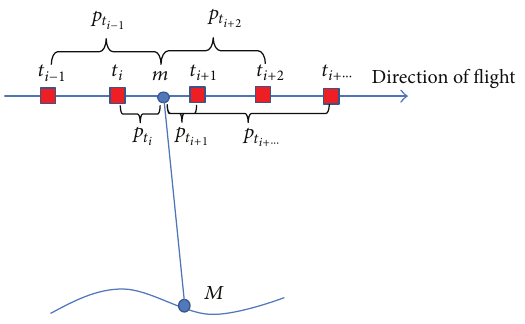
Figure 1: Diagram of piece-point with weight polynomial